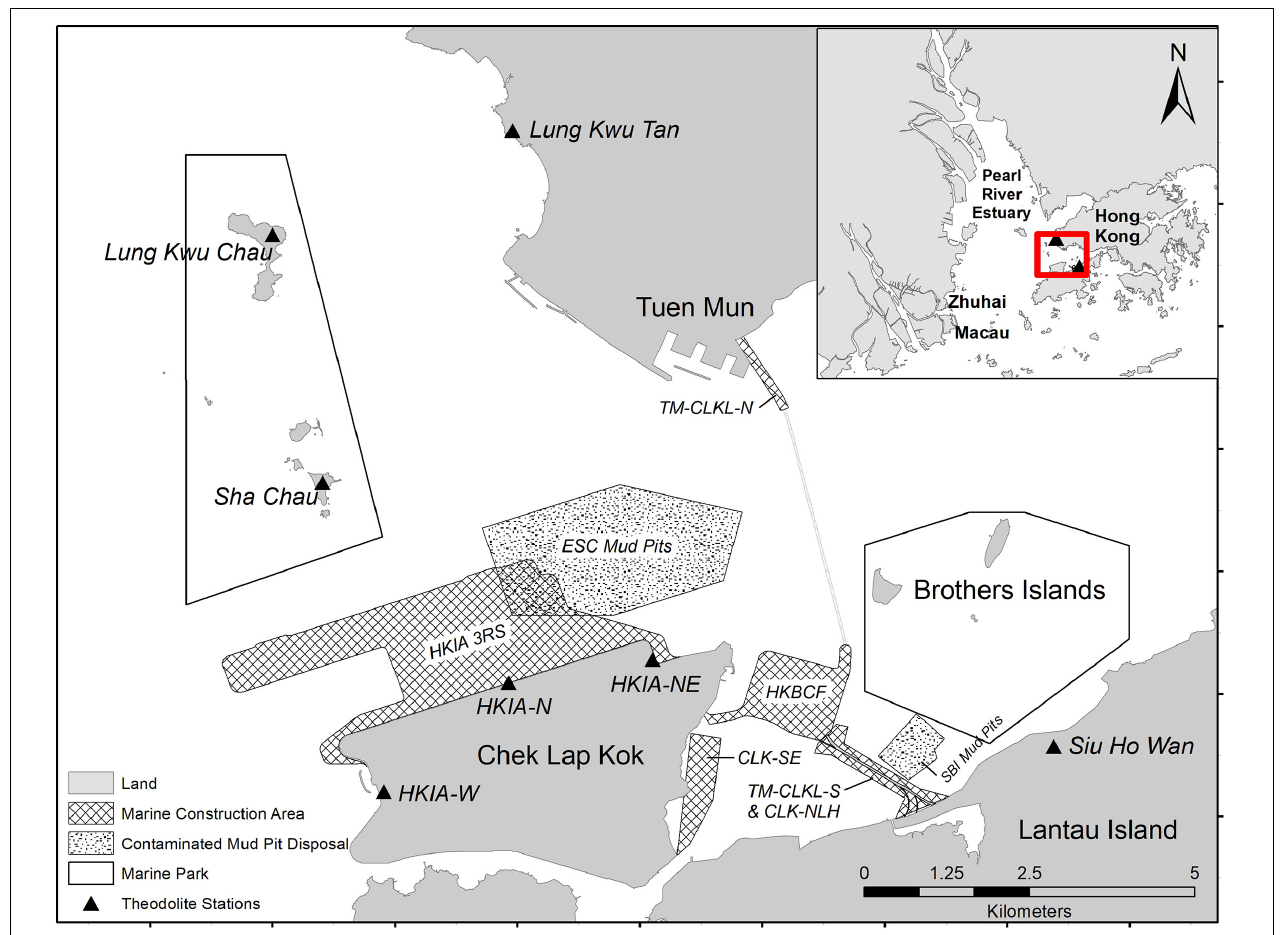
FIGURE 1 | Study area off Lantau Island, Hong Kong. Map shows land-based theodolite observation locations, marine construction and mud pit disposal areas, and marine park boundaries. Map created using ArcGIS (Version 10.2.2,